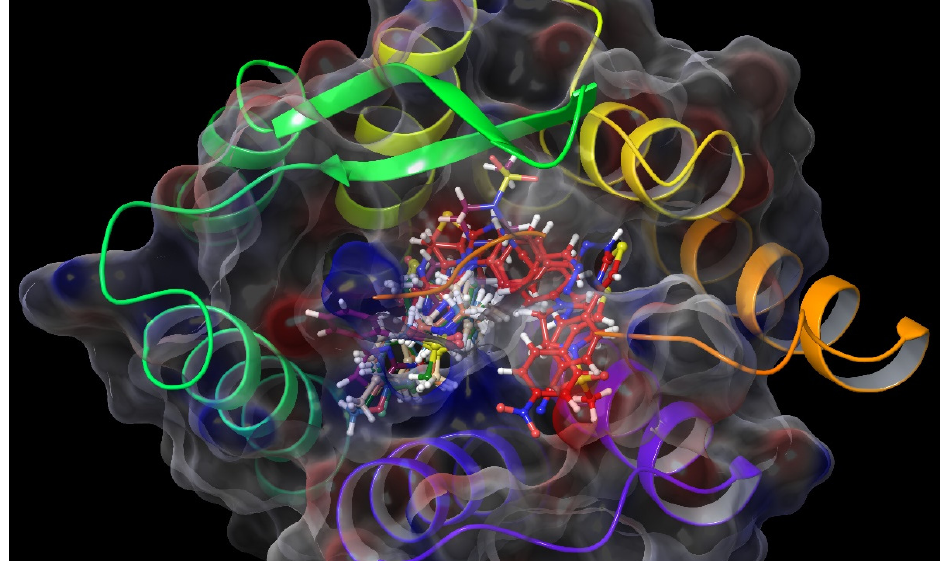
Figure 10. The three-dimensional pose of the interaction of all compounds with the µ-opioid receptor (PDB Code: 5C1M) active site. The inactive compounds ( 3d , 3e , and 3h ) are presented by a tube model colored with red.